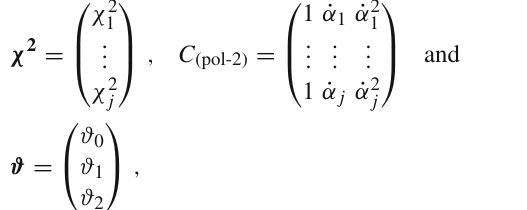
Fig. 5 Illustration of various χ 2 / n df values in the scope of the Linear Template Fit for Example 1 (Sect. 4). The red star indicates the best-fit χ 2 of the Linear Template Fit, ˆ χ 2 . The full circles display the χ 2 values of the individual templates and the red line displays the χ 2 parabola calculated from them, and its minimum is indicated with an open circle ( ˇ χ 2 , see text)